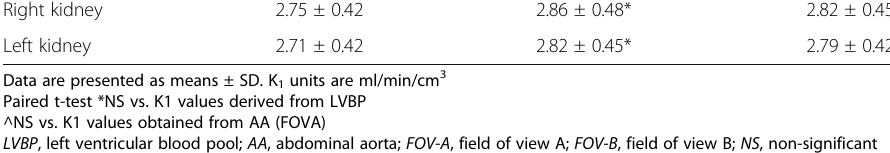
Table 2 Mean K 1 values for the investigated input functions LVBP AA (FOV-A) AA (FOV-B) Right kidney 2.75 ± 0.42 Left kidney 2.71 ± 0.42 2.82 ± 0.45* 2.79 ± 0.42 ^ Data are presented as means ± SD. K 1 units are ml/min/cm 3 Paired t-test *NS vs. K1 values derived from LVBP